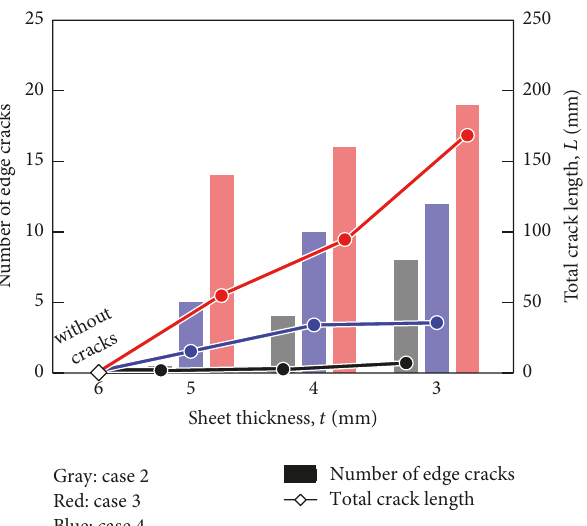
Figure 9: The statistical data on the edge cracks of the rolled sheet at each rolling temperature, sample temperature, and sheet